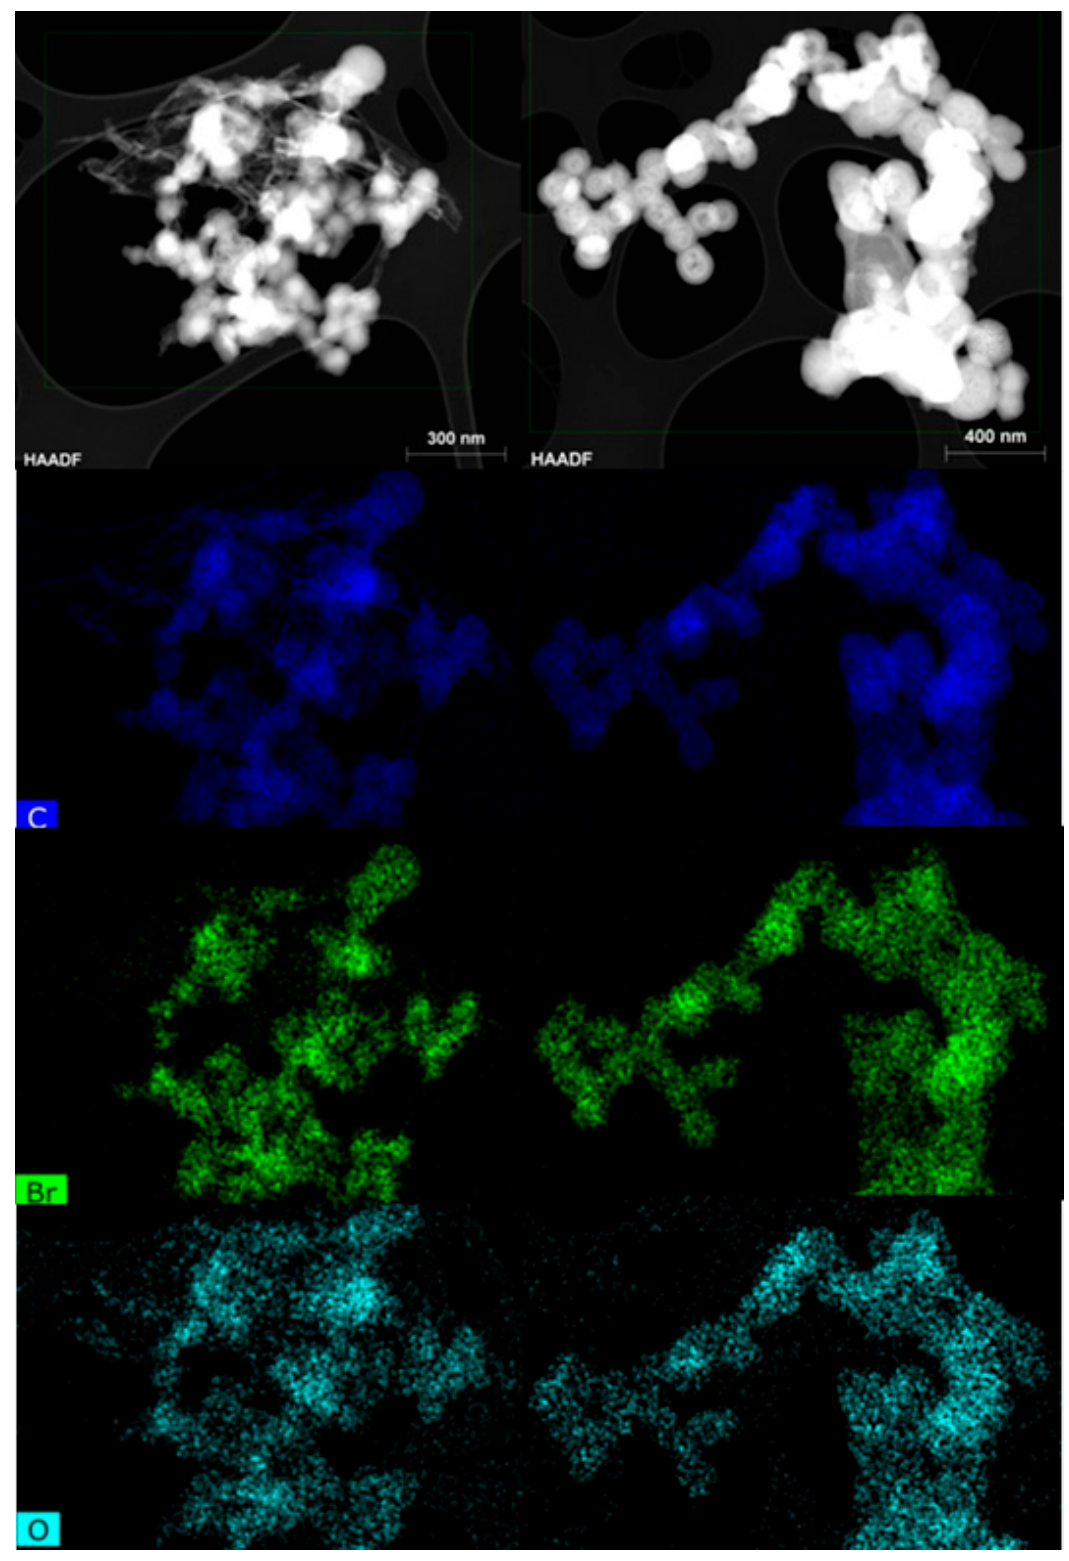
Figure 6. Chemical mapping of spherical particles ( left column ) and hollow spheres ( right column ). Deep blue color denotes C, green Br, and light green-blue O.